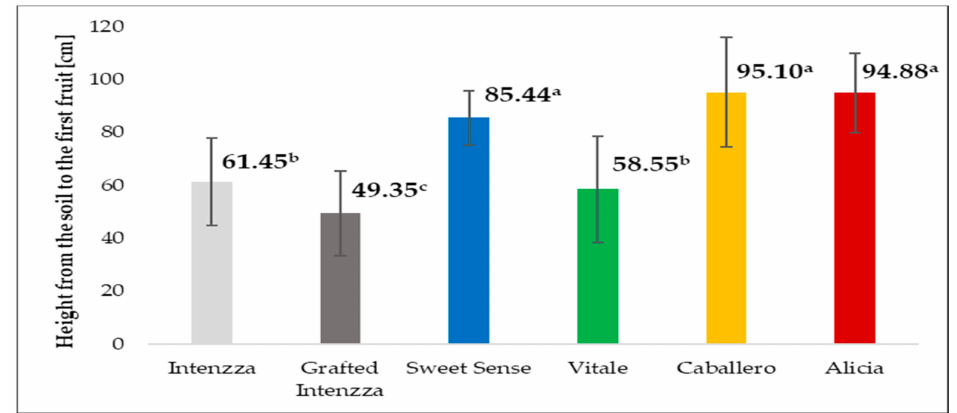
Figure 7. Height from the soil to the first fruit measured for five cultivars of papaya planted under greenhouse. Di ff erent letters mean significant di ff erences, at p -value <